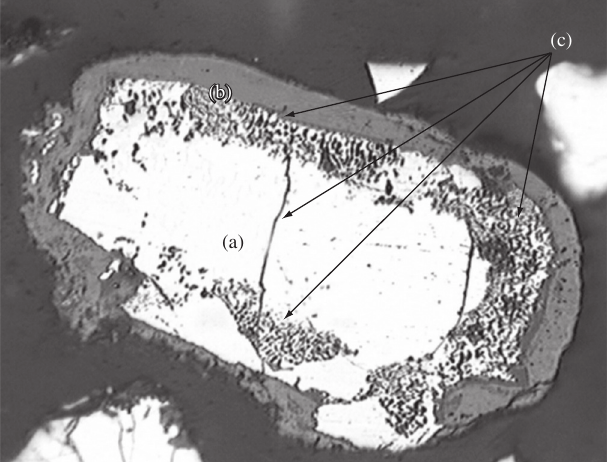
Figure 2. Optical micrograph of a HC-FeMn alloy particle aggregated to slag. 220 x . a) alloy, b) slag, and c) pore/fracture.